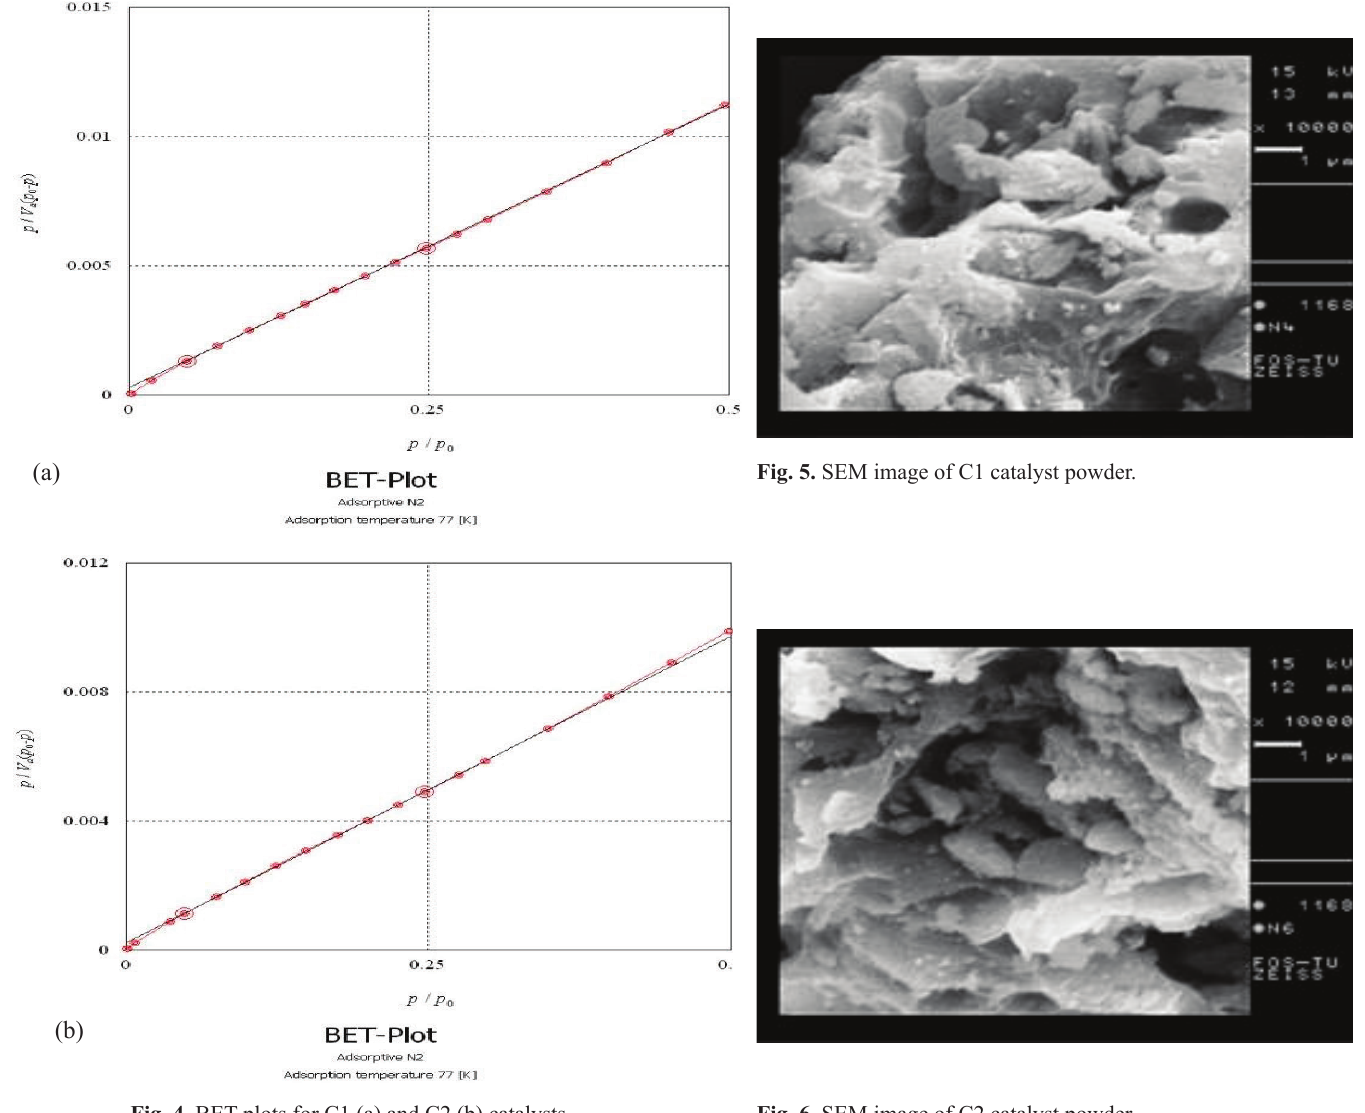
Fig. 4. BET plots for C1 (a) and C2 (b) catalysts.